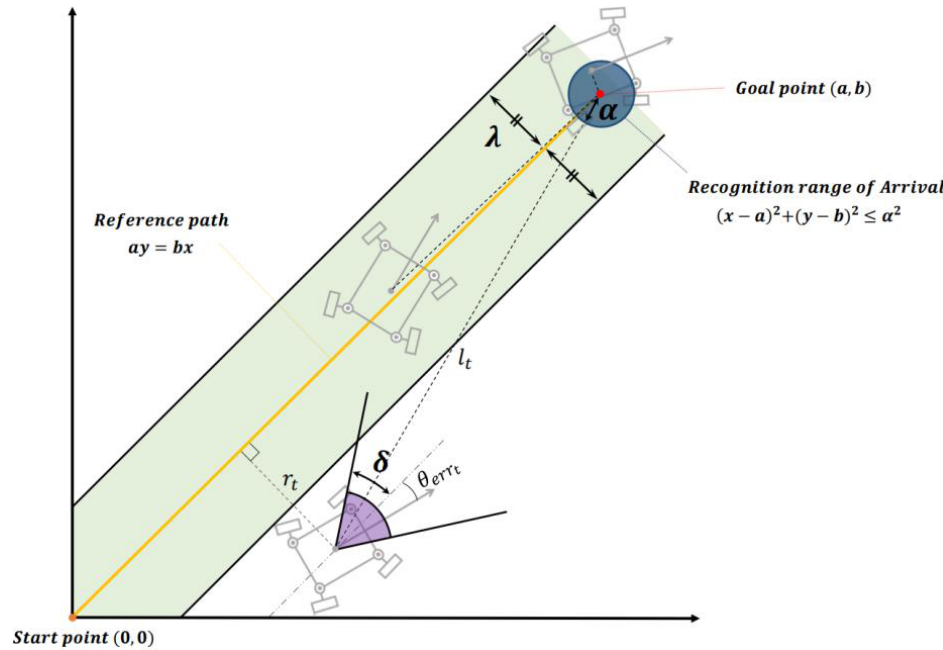
Figure 13. Reference path, along with the state values and constant thresholds used for reward dis- crimination.